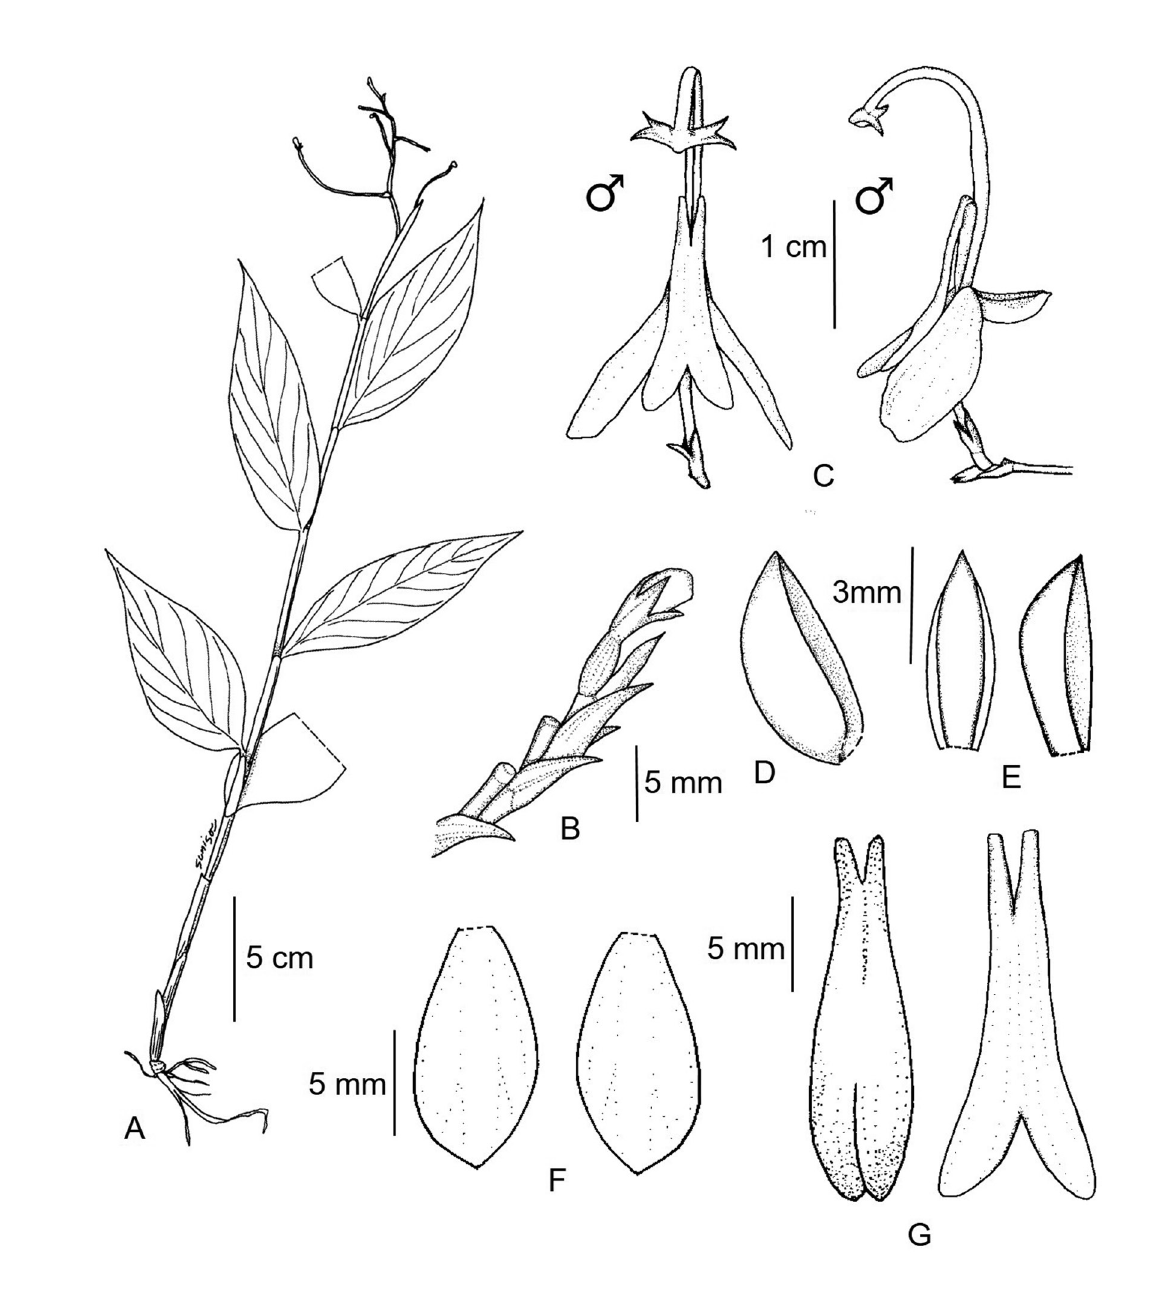
Fig. 13. Globba macrochila Sangvir. & M.F.Newman sp. nov. A . Habit. B . Crowded cincinnus. C . Flower, front and side views. D . Dorsal corolla lobe. E . Lateral corolla lobes, front and side views (same scale with D). F . Lateral staminodes. G . Variation of labellum shape. Drawing: S. Sangvirotjanapat from